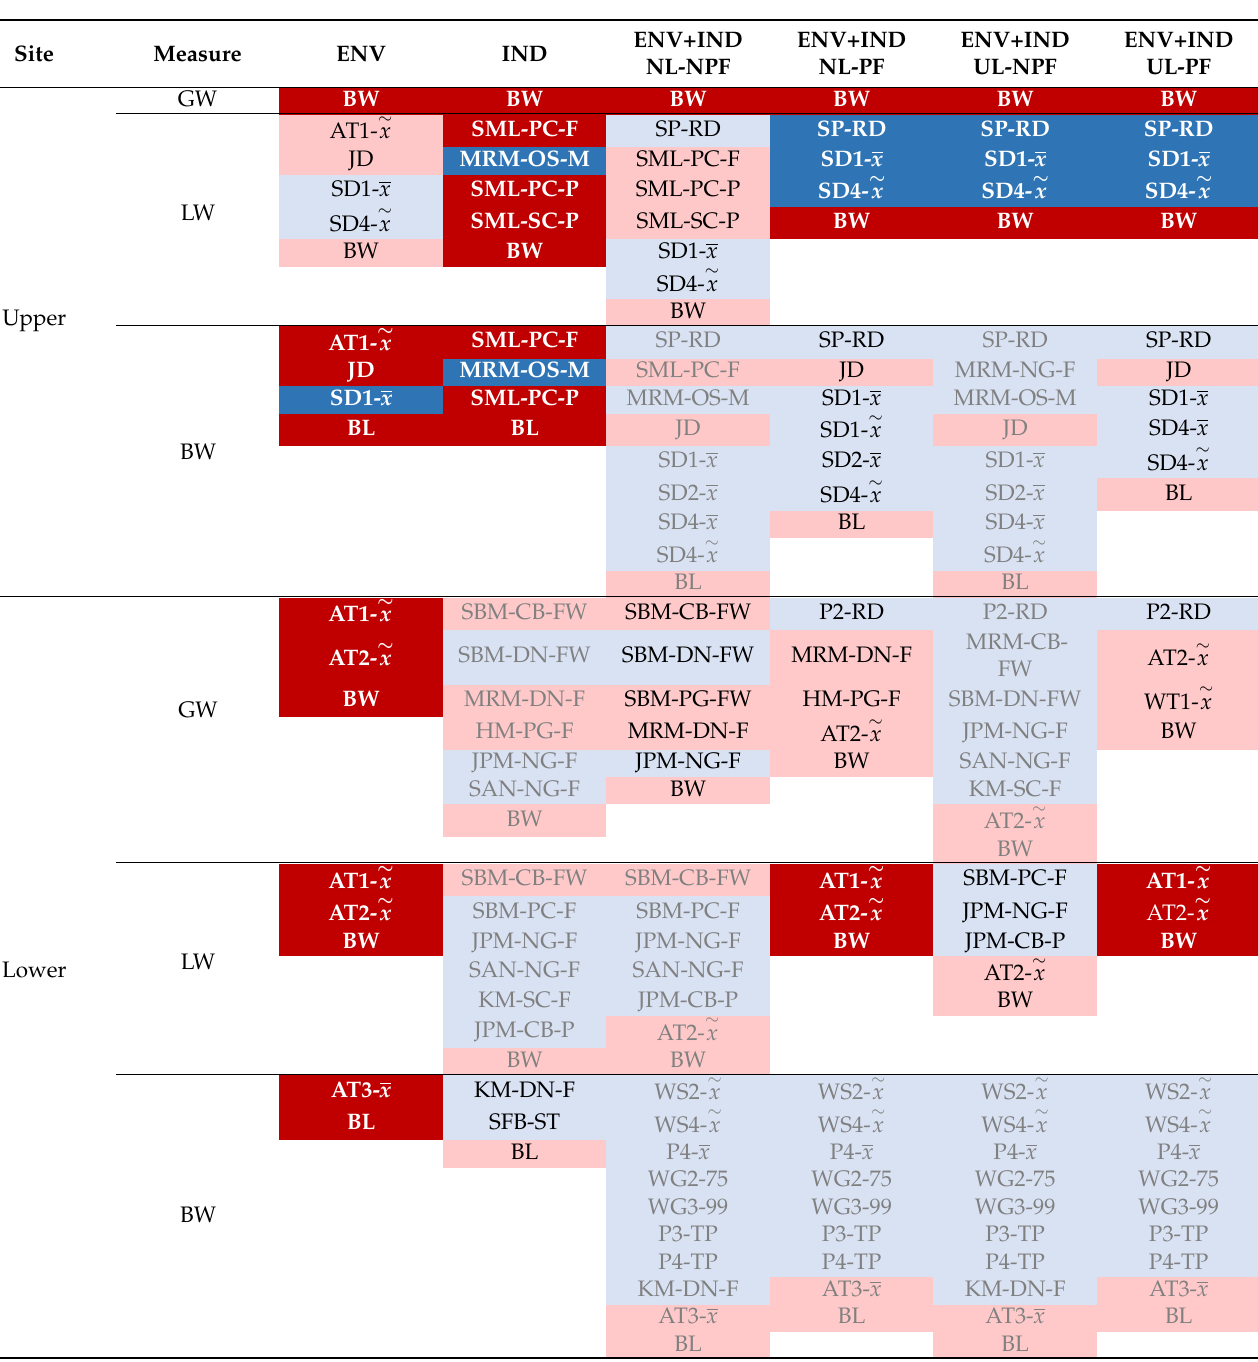
Table 2. Environmental and industrial covariates selected by EN for gonad weight (GW), liver wight (LW), and body weight (BW) of male fish captured at the Upper and Lower Ells locations; NL = no limits; UL = upper limits; NPF = no penalty factors; PF = penalty factors; bolded white text with saturated fill color in cells comprise best-fit judged by AIC values; red = positive coefficients; blue = negative coefficients; marginal models indicated as unsaturated fill and black